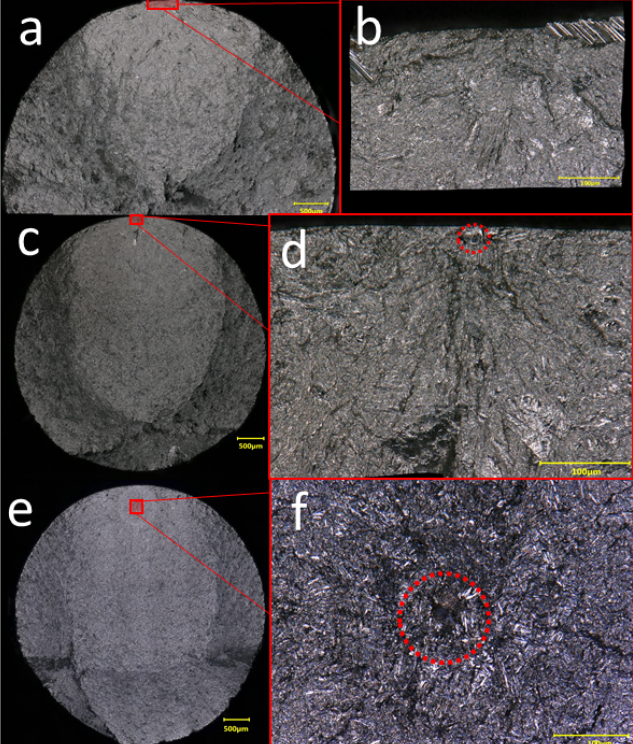
Figure 4. Two different fatigue crack initiation modes observed in AM Ti-6Al-4V having undergone standard HIP; ( a , b ) fracture surface of standard HIP’d specimen with medium initial defect density (SH-M) showing that failure initiated independent of build defects. Note in ( b ) there is no clear nucleation site. Fracture surface of ( c , d ) standard HIP’d specimen with low defect density (SH-L) and ( e , f ) high defect density (SH-H) where failure initiated from